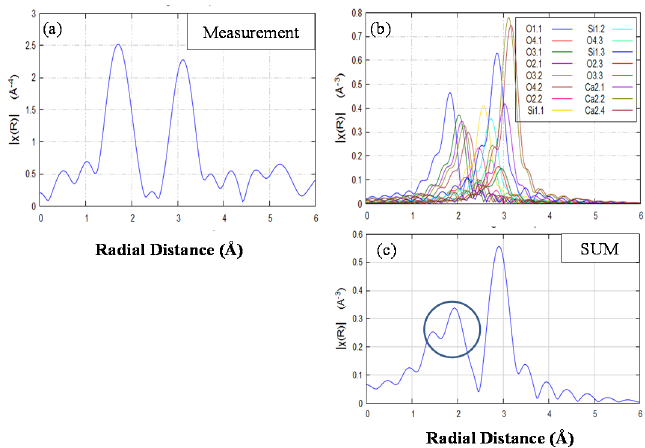
Figure 8. Radial structure function of (Ca 1.95 Eu 2+0.02 □ 0.03 )(Si 0.94 P 0.06 )O 4 phosphor annealed at 1473 K in ( a ). ( b ) Simulation spectra, in which the Eu ion is substituted in the Ca(1n) site in β -Ca 2 SiO 4 . ( c ) Calculated peaks as a sum of each peak shown in ( b ).